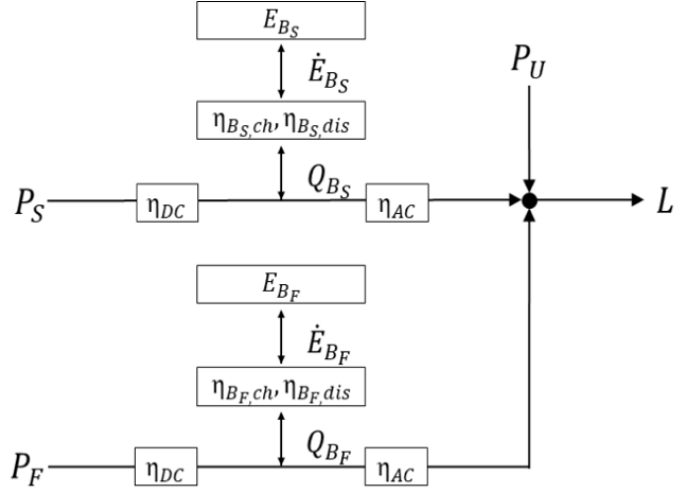
Figure 2. Schematic diagram of solar, fuel power battery, and power utility energy hub